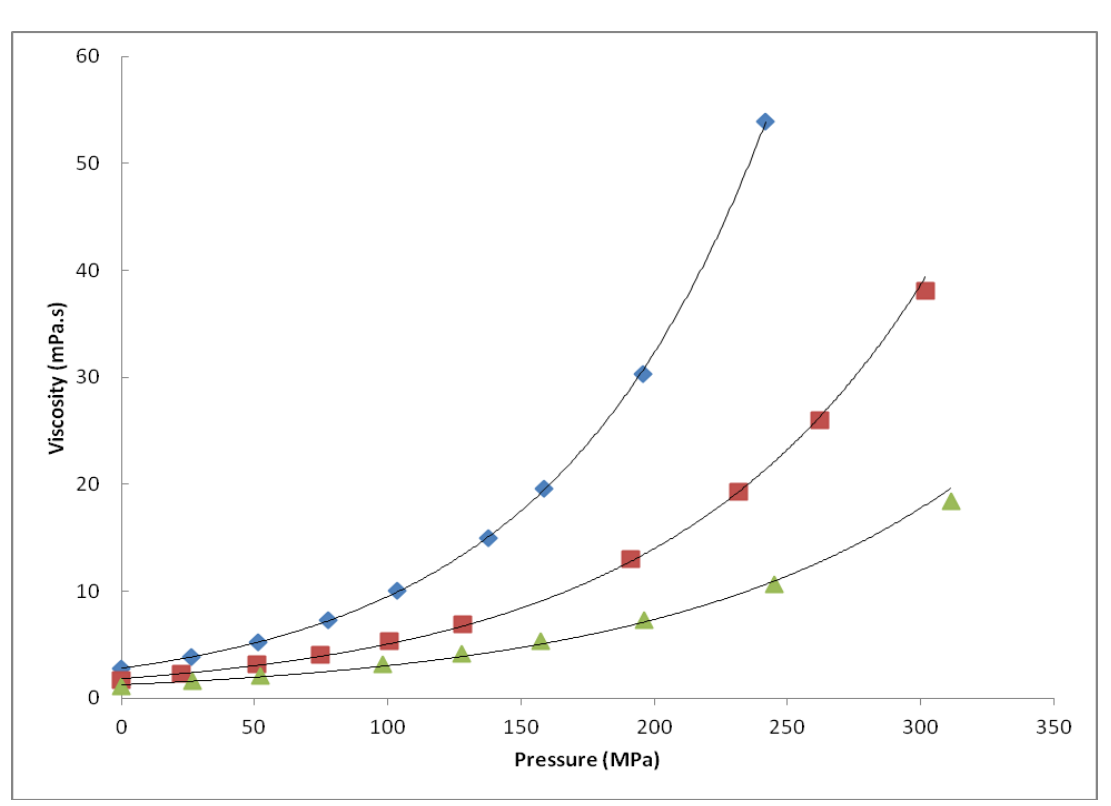
Figure 10. Variation of viscosity for Fuel 5 with temperature. ♦ 298 K, ■ 323 K, and ▲ 348 K.